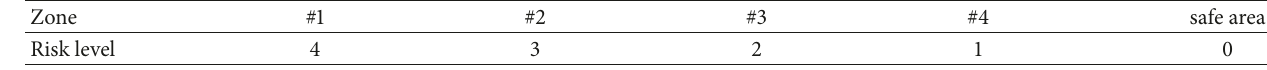
Table 1: Risk level of the zones in Figure 2 based on gas concentration.